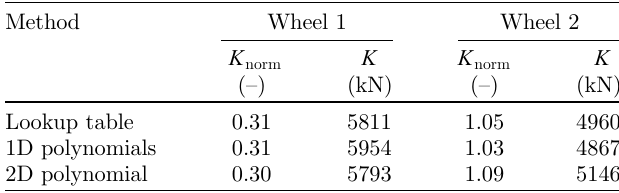
Table 4. Summary of example results.